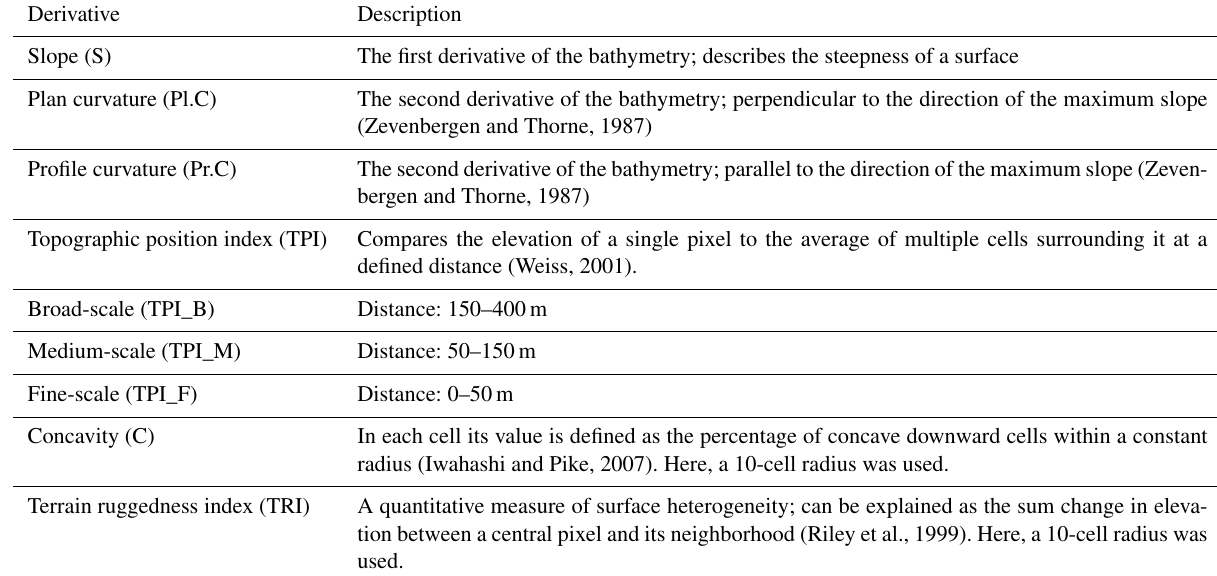
Table 1. The bathymetric derivatives computed in SAGA GIS and used as predictor variables. Derivative